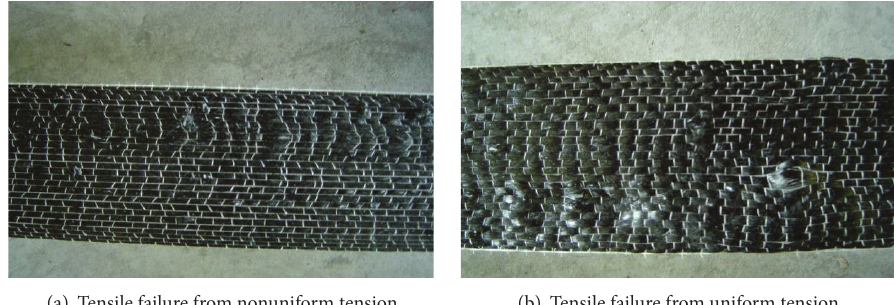
Figure 3: Different jack-up failure modes of the CFRP sheet.